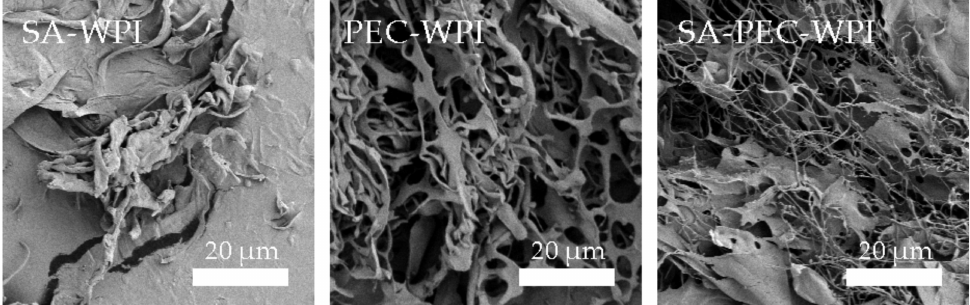
Figure 4. The SEM images of SA-WPI, PEC-WPI, and SA-PEC-WPI stabilized β -carotene emulsions. SEM: scanning electron microscope; SA: sodium alginate; PEC: pectin; WPI: whey protein